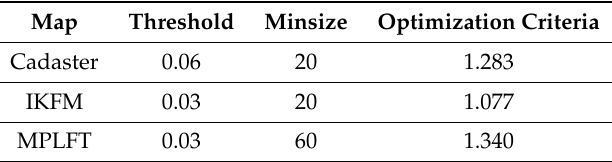
Table 1. Values of the optimized segmentation parameters for the test maps. Minsize in pixels. The optimization criteria is the sum of the normalized intra-object Variance Weighted by object size (VW) and Spatial Autocorrelation (SA) parameters described in Section 4. Map Threshold